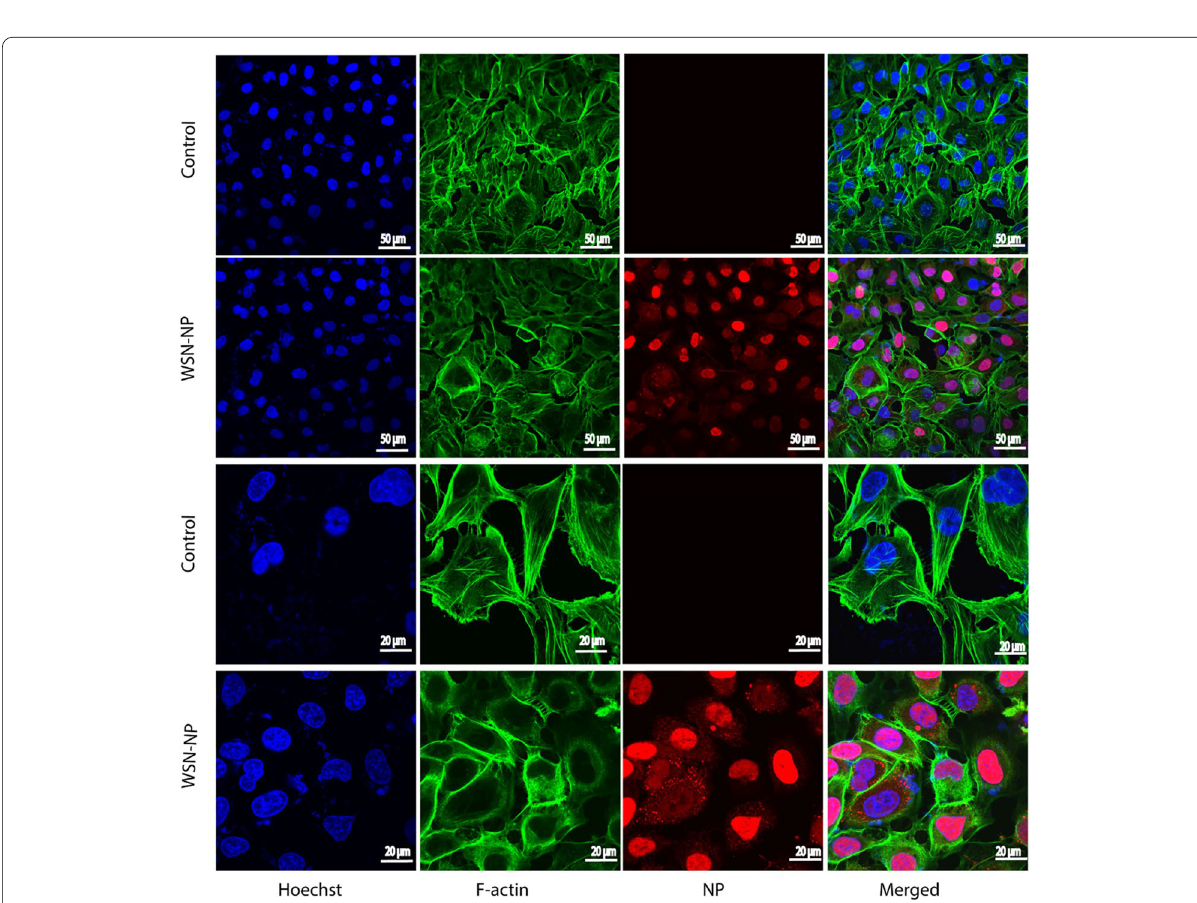
Fig. 2 Immunoflourence for human brain microvascular endothelial cells (hBMECs) at 12 hpi with Influenza A virus. hBMECs were mock-treated or infected with A/WSN/33 (H1N1) virus at 0.1 MOI. After 12 h, the cells were stained with anti-NP (red), Phalloidin for F-actin (green), and Hoechst for nucleic acid stain (Blue). Images were captured by confocal microscopy. The column “Merged” is generated by the machine software, which is produced by positioning the “red”, “green” and “blue” fluorescence of the same cells within the same optical plane: scale bar 50, 20